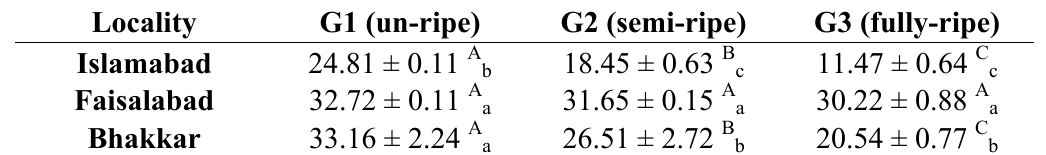
Table 2. Total phenolic contents (mg GAE 100 g − 1 dry wt.) of extracts from guava fruit collected at different stages of